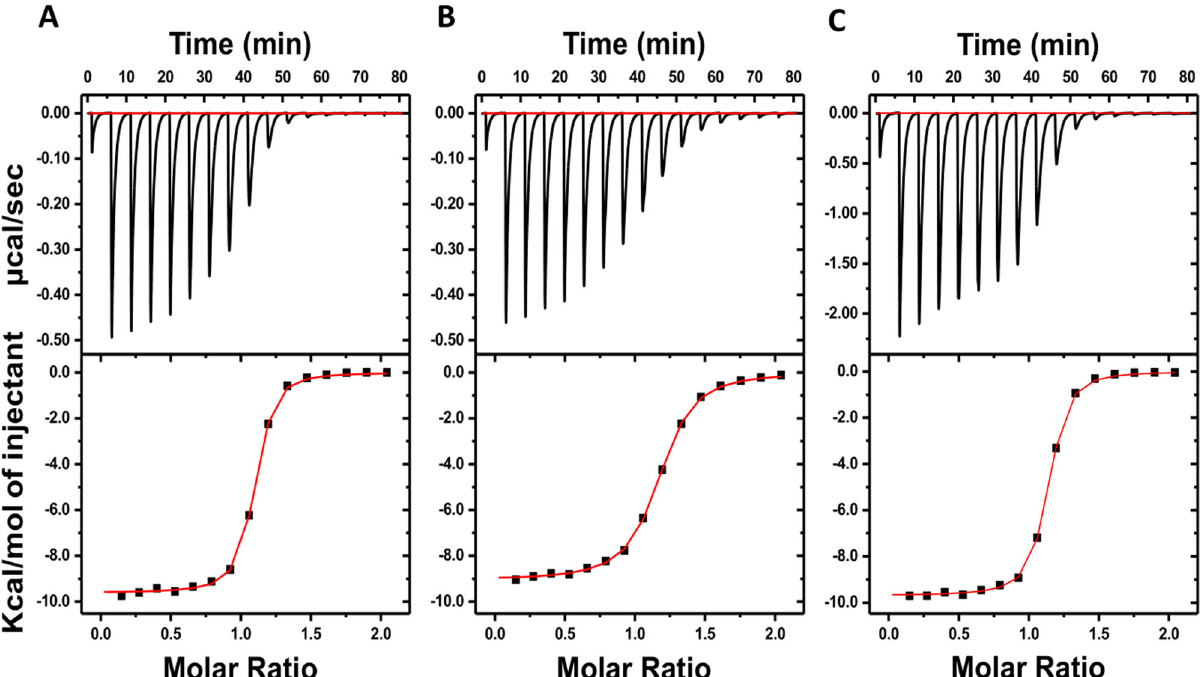
Fig. 3 Isothermal titration calorimetry of ligand-hits with TphC. To ascertain the binding interaction of ligand hits and to determine the corresponding thermodynamic parameters for the interactions between the ligands and TphC, isothermal titration calorimetry was employed. A Terephthalate 1 against 100 μ M TphC. B 2-Hydroxyterephthalate 4 against 100 μ M TphC. C 2,5-Dihydroxyterephthalate 10 against 500 µ M TphC. Experiments were performed at 22 °C at a fi xed protein to ligand ratio of 1:1:10 in Tris-HCl buffer (25 mM Tris-HCl, pH 7.5/200mM NaCl), with 2.5 μ L ligand injections with 300 s interval between each injection. Corrected heat rates are shown in the top panel and normalised fi t to the data in the bottom panel. Table 1 Thermodynamic parameters for binding interactions of ligand-hits with TphC. Ligand N sites a